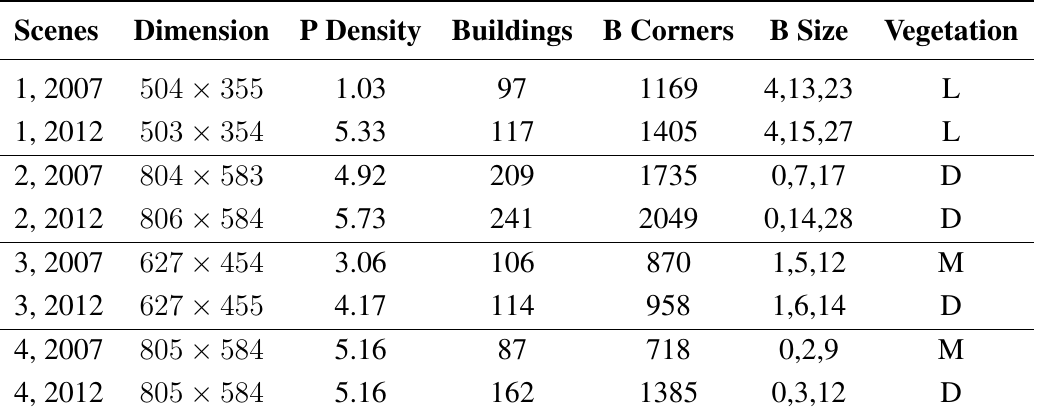
Table 1. Four test datasets, each from two dates: dimensions in metres; point density in points/m 2 ; B corners are the total number of corners in all reference buildings; B size indicates the number of buildings with 10 m 2 , 25 m 2 and 50 m 2 in area, respectively; vegetation: D = dense, M = moderate and L =